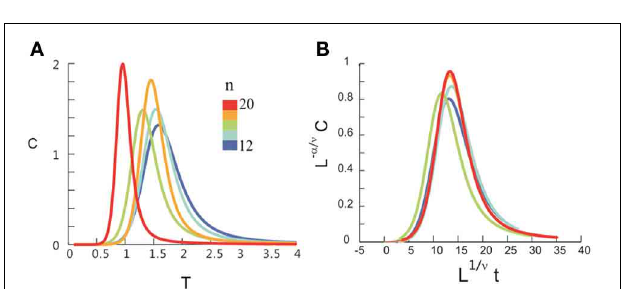
FIGURE 12 | Dissociation between the scaling/collapse and the power-law size distribution. Pattern probabilities of the original data (as shown in Figure 4 ) were modified so that the probability for the quiescent state, p 0 , was set randomly from a uniform distribution (0, 1) while the probabilities for all other states were renormalized, i.e., p i = p i /( 1 − p 0 ). Therefore, the power-law size distribution was preserved. (A) , Specific heat, C , is plotted as a function of T for system size n = 12 – 20 (color coded). (B) No collapse can be achieved.